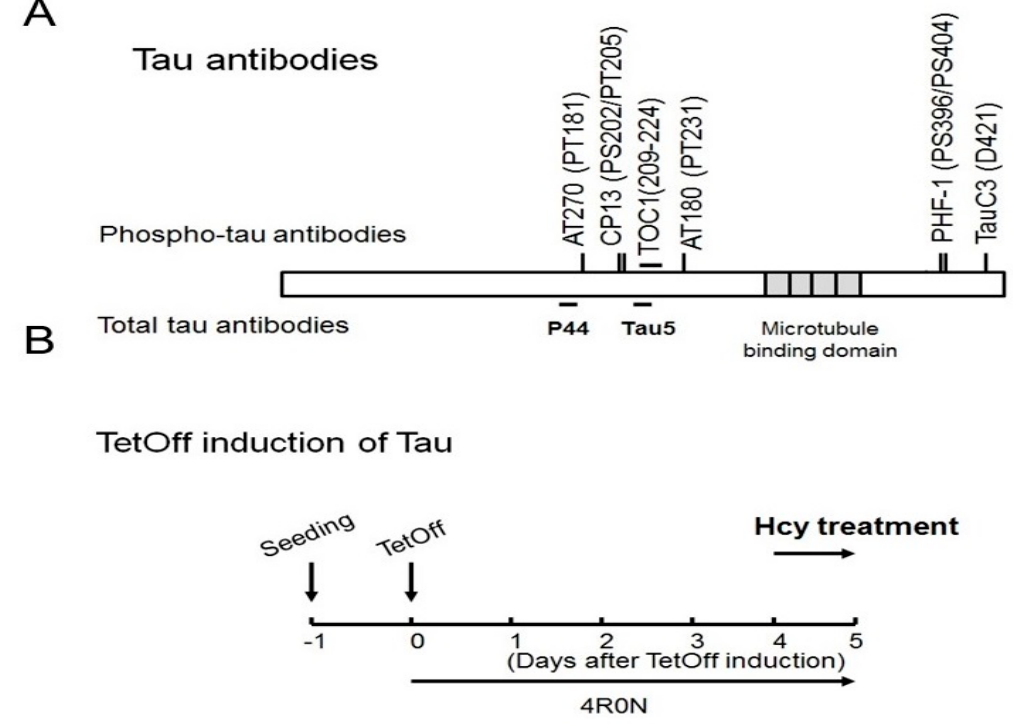
Figure 14. Tau antibodies used in this study and the experimental timeline. Schematic depiction of human 4R0N tau and different epitopes recognized by tau antibodies used in this study ( A ). Schedule of induction of tau expression in M1C cells with tau controlled under a tetracycline off (TetOff) expression system. On Day 0, induction of tau expression was started by reducing the concentration of tetracycline in the medium from 2000 to 1 ng/mL. On Day 4, L-Hcy treatment was started and on day 5 the cells were harvested ( B ).